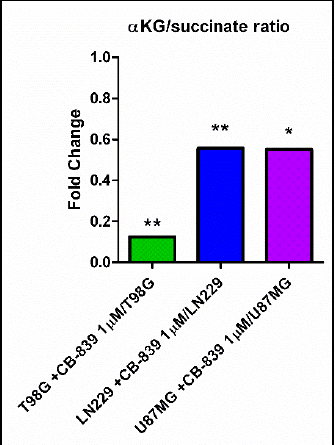
Figure 15. Specific GLS inhibition by CB- 839 highly decreased αKG/succinate ratio for all assayed GBM cell lines. The samples were run in triplicate. For further details, see Section 2. * p < 0.05, ** p < 0.01.